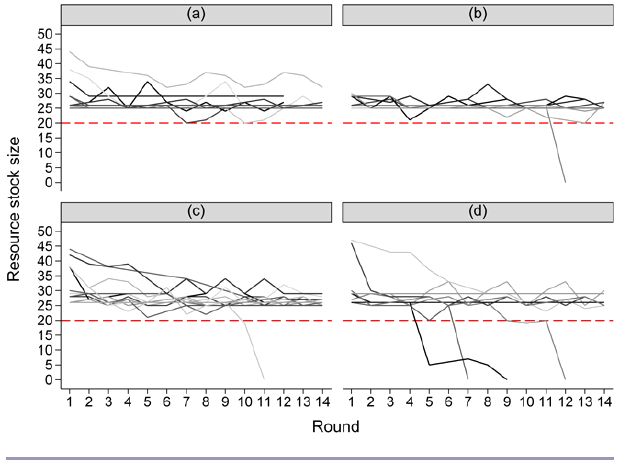
Fig. 3 . Time series of resource stock size after group harvest and before growth for each cooperative group of the threshold treatment (a) with N = 16, high-risk treatment (b) with N = 9, medium-risk treatment (c) with N = 17, and low-risk treatment (d) with N = 9. Data points below the red dashed line (potential threshold) indicate severe overexploitation, i.e., crossing of the potential threshold. Note that a group that crossed the potential threshold and depleted the resource stock in the same round was not classified as a group that severely overexploited the resource; this applies only to one group in graph (d). Bear in mind also that these graphs do not say anything about whether the groups that crossed the potential threshold actually played scenario B. Three groups in graph (a) played fewer than 14 rounds and therefore the time series stopped earlier.